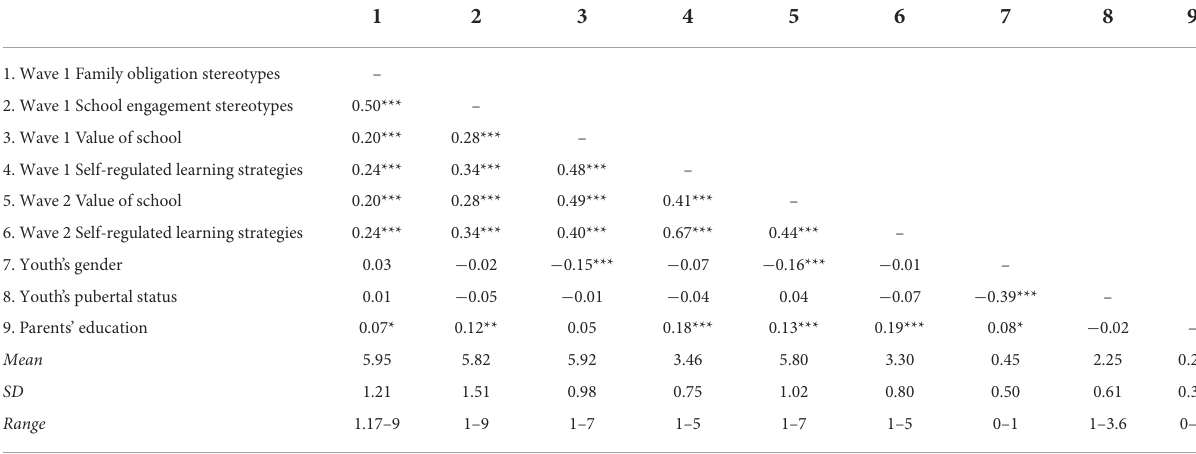
TABLE 1 Descriptive statistics and correlations between the